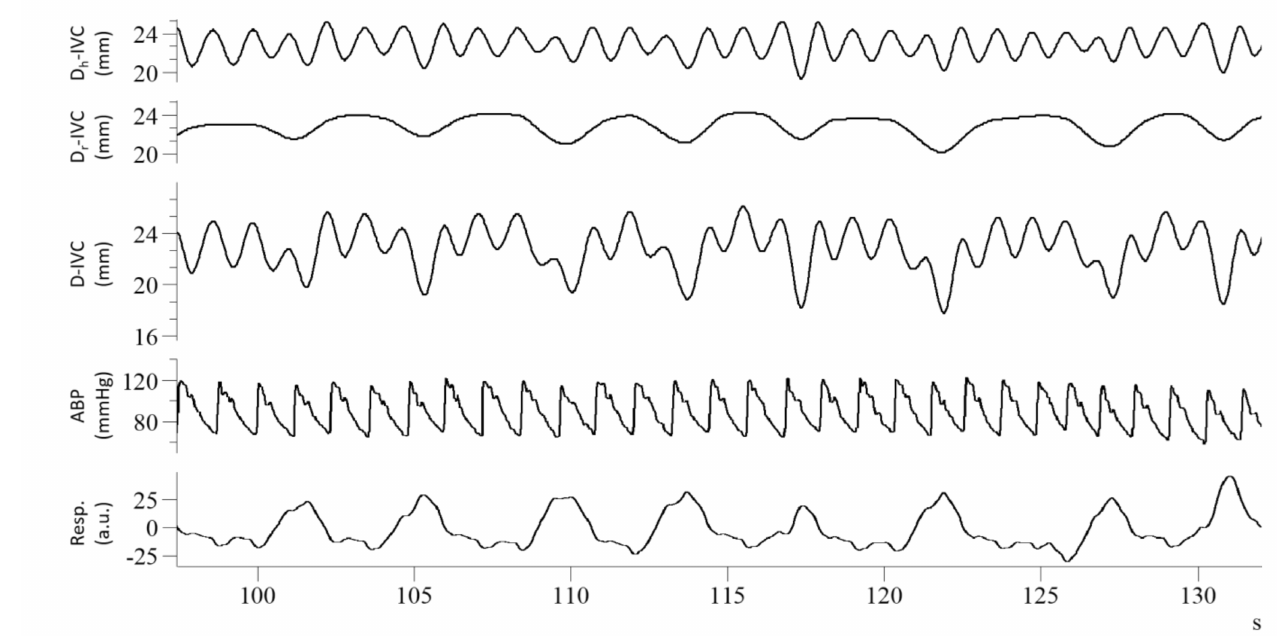
Figure 1. Recordings from a healthy subject: from top to bottom, cardiac component of IVC pulsatility (Dc-IVC), respiratory component (Dr-IVC), unfiltered IVC pulsatility (D-IVC), arterial blood pressure (ABP), respiratory movements (Resp), long axis IVC imaging was processed according to Mesin et al., 2019